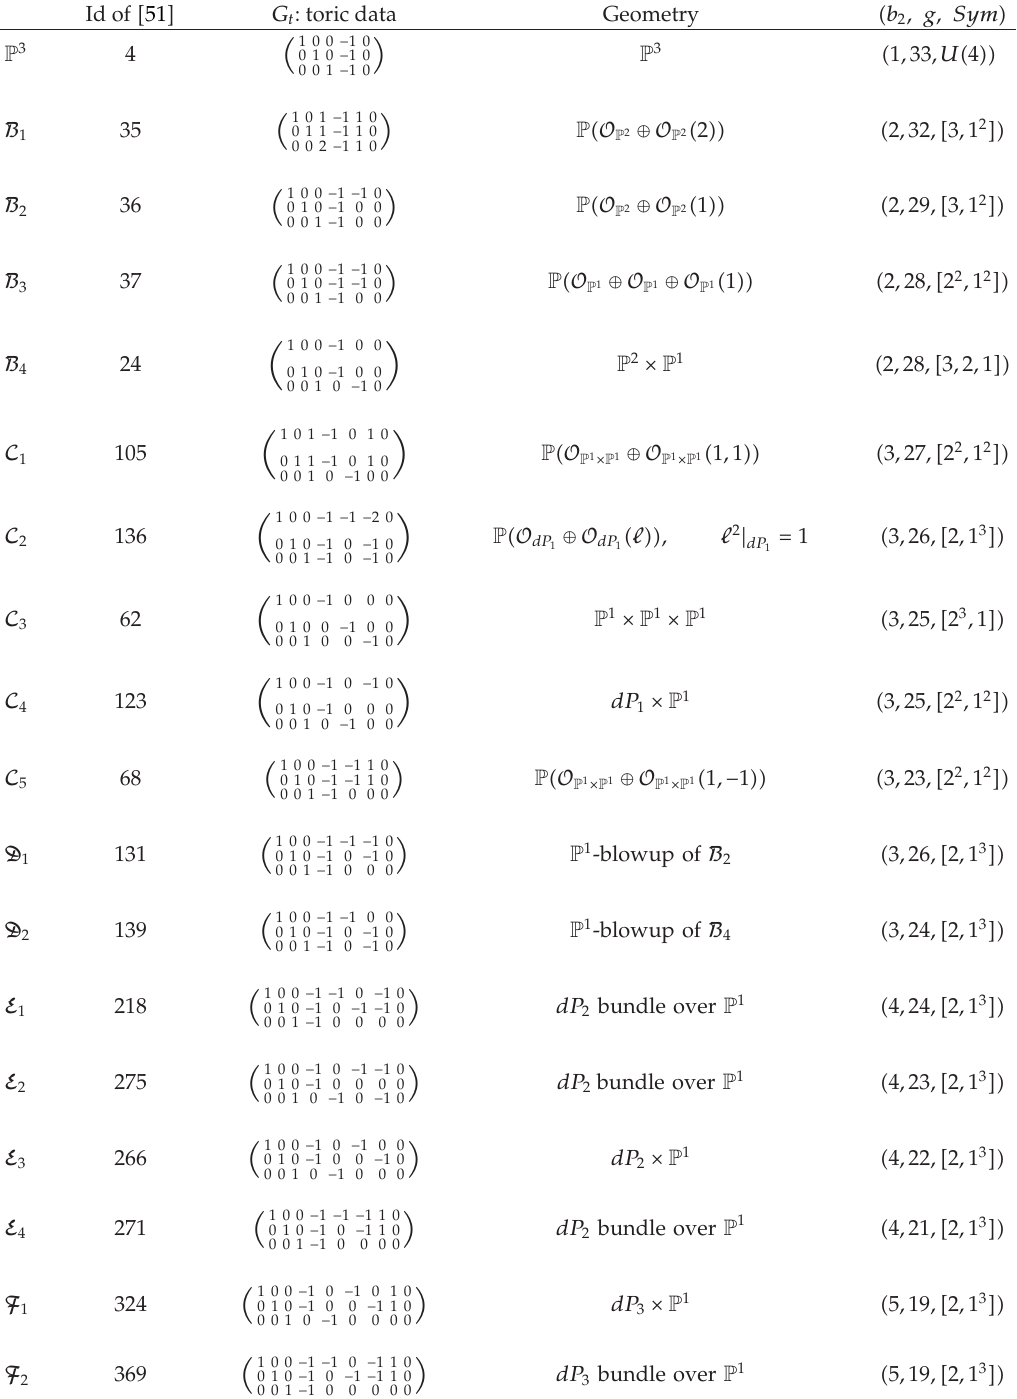
Table 2: The 18 smooth toric Fano threefolds. For full explanation of notation, see the second paragraph of Section 2.1 and those that